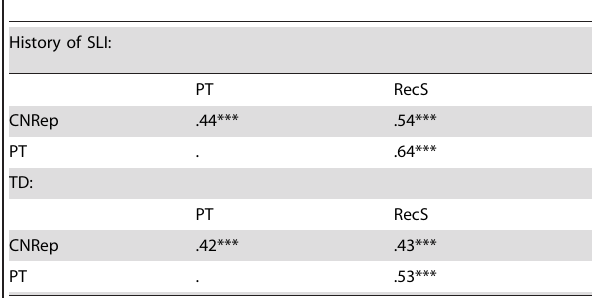
Table 4. Correlations between memory, morphology and recalling sentences raw scores for children with a history of SLI and TD children.